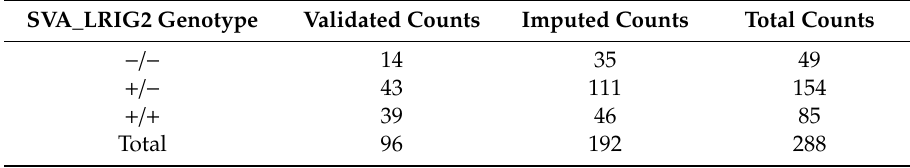
Figure 3. Representative image of NABEC DNA samples following PCR with primers targeting regions flanking SVA_LRIG2. A 1.9 kb PCR product corresponds to SVA_LRIG2 being absent from the locus and a 4.3 kb PCR product corresponds to SVA_LRIG2 presence. Sample genotypes are displayed along the bottom. NTC = Non-template control. Red asterisk indicates formation of non-specific PCR products of approximately 1.5 kb. Table 1. SVA_LRIG2 RIP genotype counts in NABEC samples.